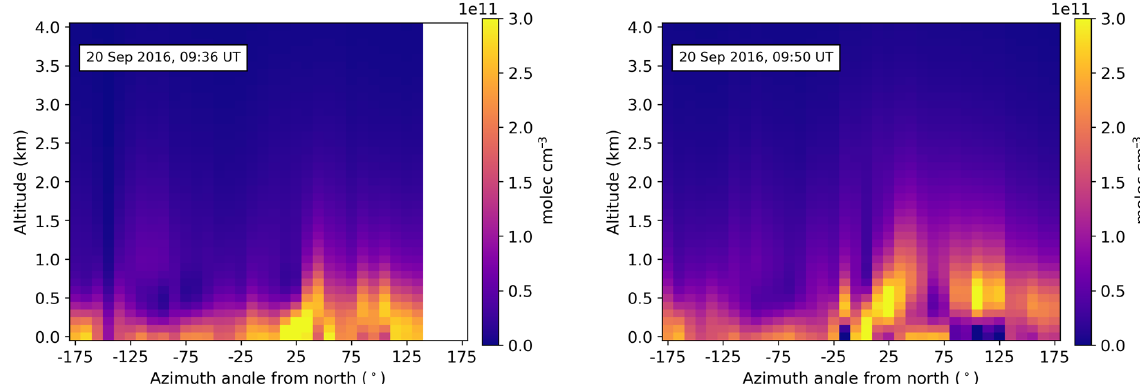
Figure 14. Retrieved NO 2 profiles around the measurement site during the observed transport event on 20 September